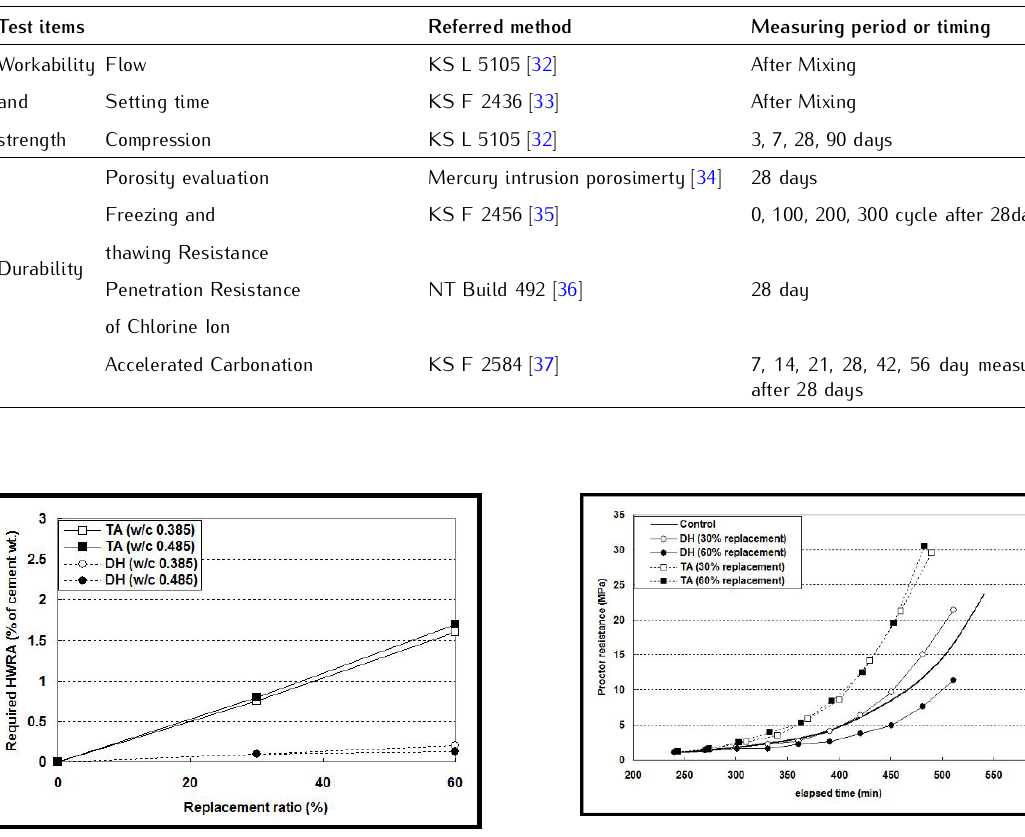
Figure 5. Required HWRA amount with different PA.